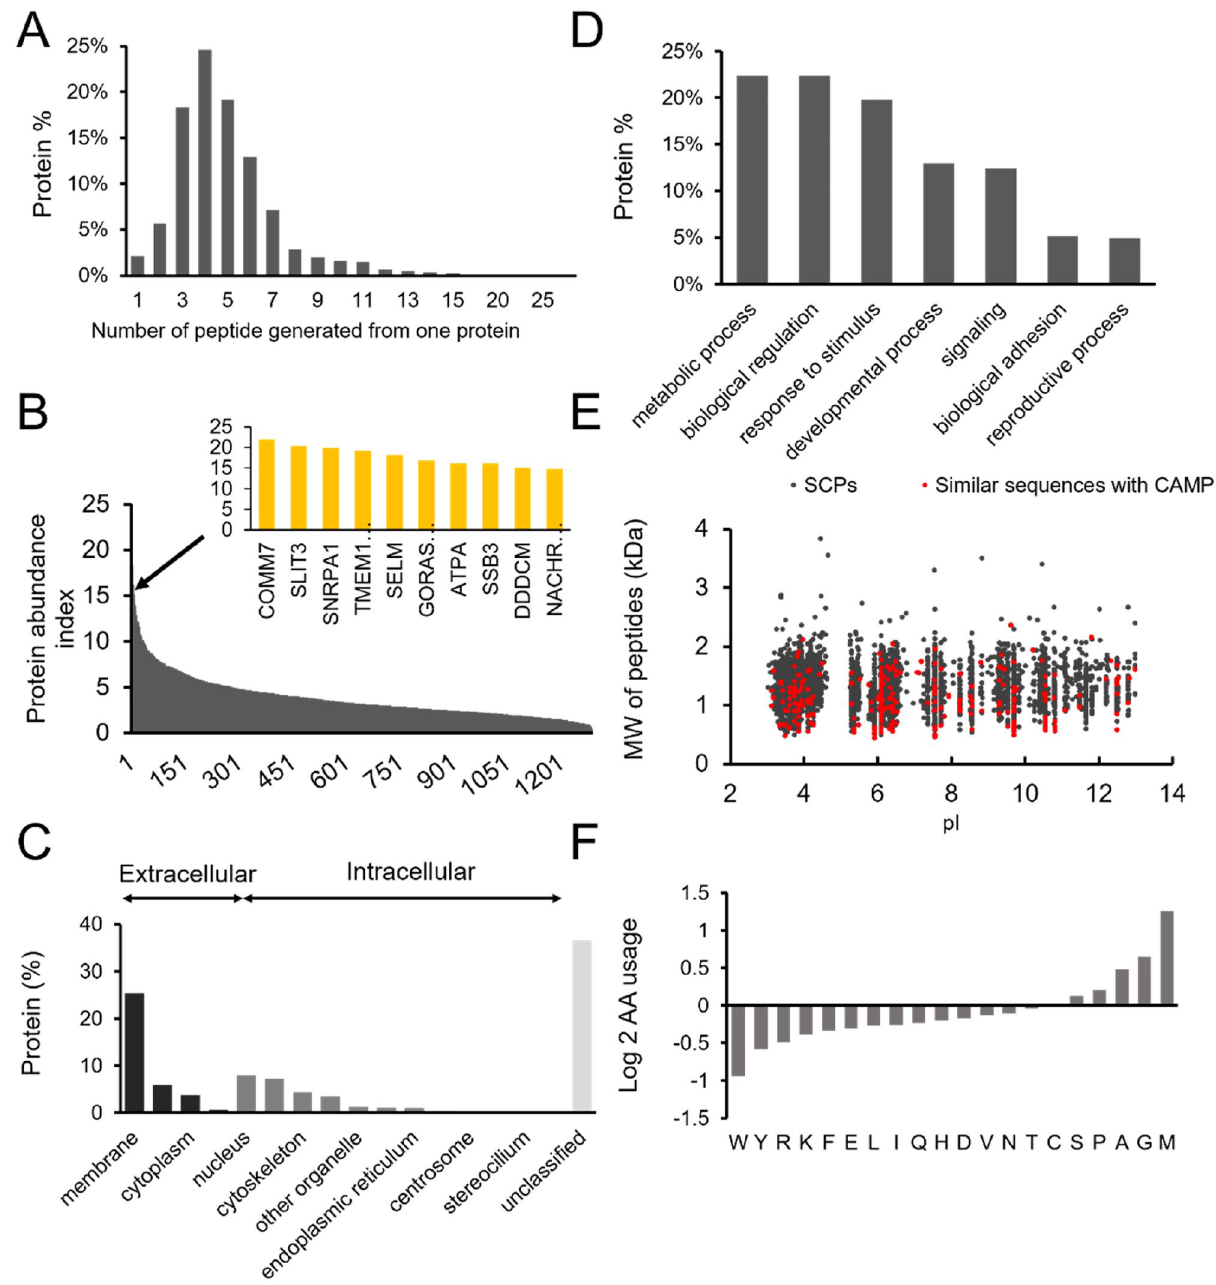
Figure 1. Characteristics of fish SCPs. ( A ) Distribution of SCP numbers produced per parent protein. ( B ) Identity of proteins that give rise to the highest number of SCPs. ( C , D ) Gene ontology enrichment analysis of parent proteins in terms of biological processes and cellular components. ( E ) Distribution of molecular weight and isoelectric points of all SCPs identified in this study. Red dots represent SCPs that are homologous to existing AMPs. ( F ) Amino acid usage of SCPs, relative to amino acid usage of available medaka